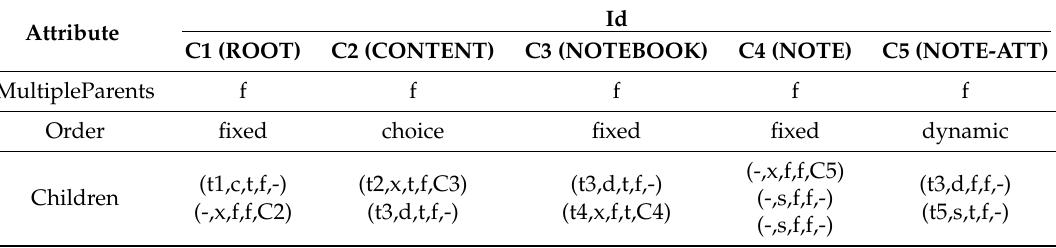
Figure 6. Template Table Notebook example. Symbol ‘@’ is used to represent the place-holders’ positions. Table 2. Schema Context Notebook example, after Context Collapsing . The content of the Children row represents the tuple ( Template , Type , IsOptional , IsArray , Context ). C n represents the eContext Id and t n the template identifier; x denotes the complex value, s string , c the constant , d the date-time , t T RUE and f F ALSE